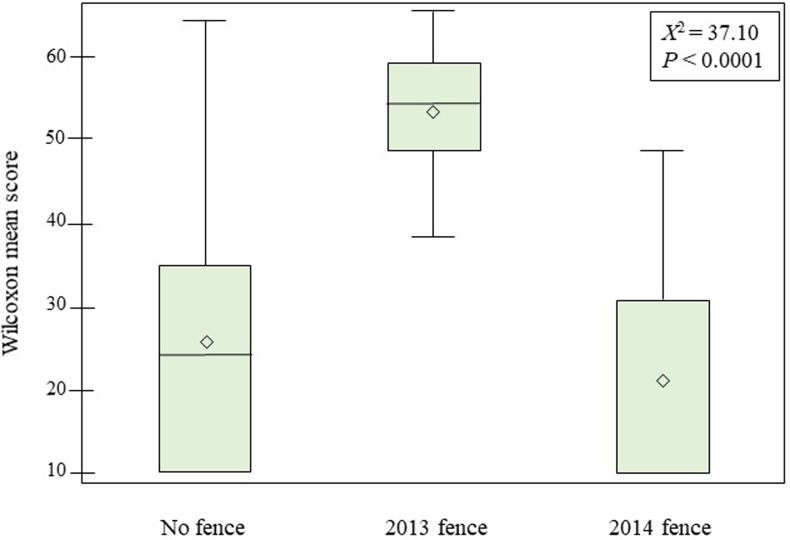
Box plots depicting a significant difference (χ2 = 37.10, p < 0.0001) in terms of the Kruskal–Wallis test for differences between treatments (groups) of regeneration ha-1.Output from Kruskal–Wallis test is shown in Wilcoxon mean scores on the y-axis (SAS®). Whiskers show minimum and maximum values, boxes represent 25–75% data ranges, horizontal lines within boxes are medians (no line indicates Wilcoxon score of zero), and diamond symbols are means. Results are considered significant where a Monte Carlo-simulated chi-square test using 10,000 runs produced an estimated p-value of <0.05.